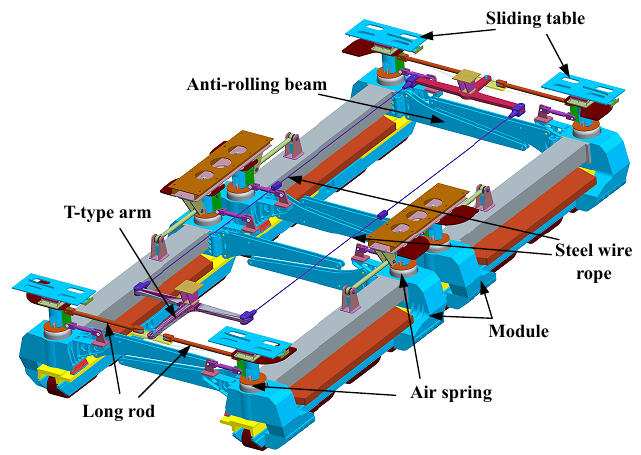
Figure 1. The suspension frame and secondary system in